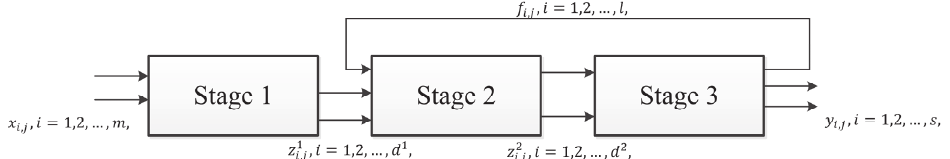
Fig. 1. Three stage model with feedback for the middle